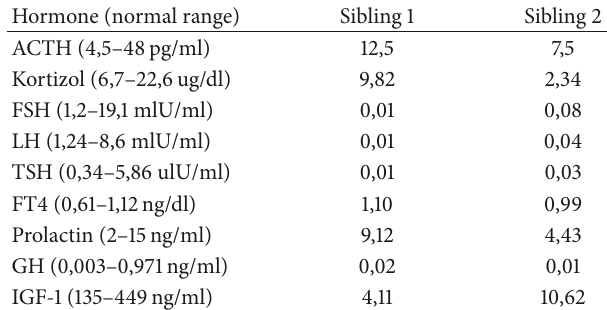
Table 1: Baseline hormone levels of sister